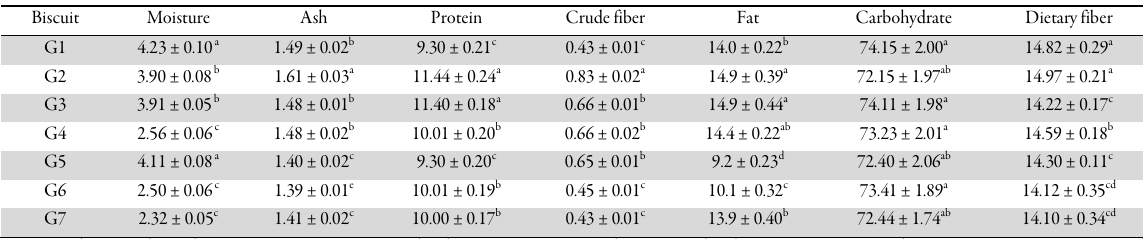
36 Table 9. Chemical composition (%) of colored barley flour biscuit contained different levels of natural and synthetic color Biscuit Moisture Ash Protein